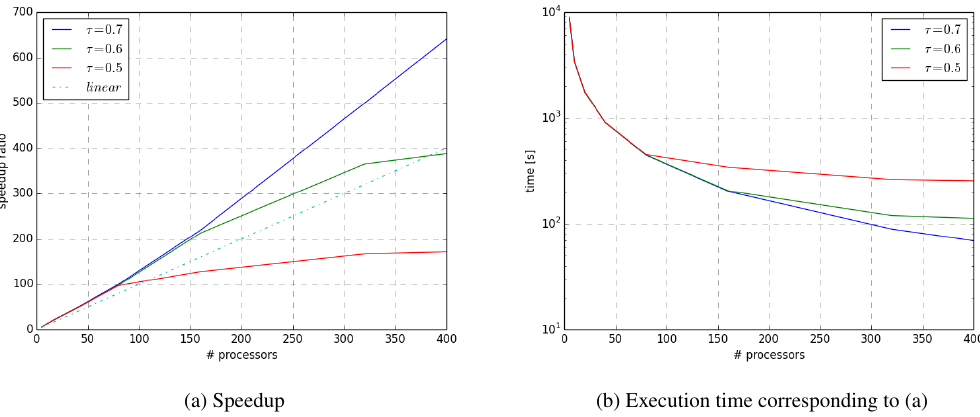
Figure 2. Mean (a) and standard deviation (b) of the daily SSH (units in cm) for year 136 of the POP control run as in (Weijer et al., 2012).